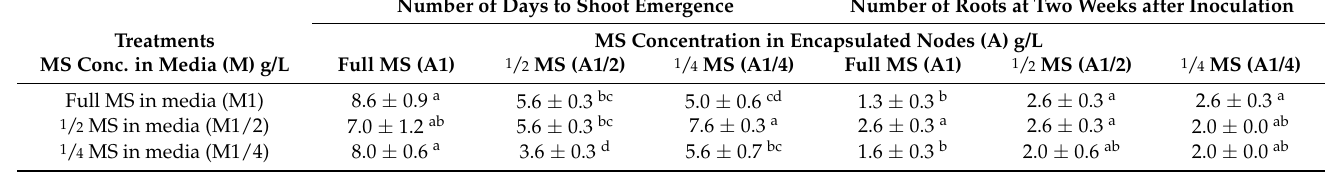
Table 2. Interaction of MS salts concentration in encapsulated sweet potato ( Ipomoea batatas L.) nodes (A) and growth media (M) on number of days to shoot emergence and number of roots at two weeks after inoculation.